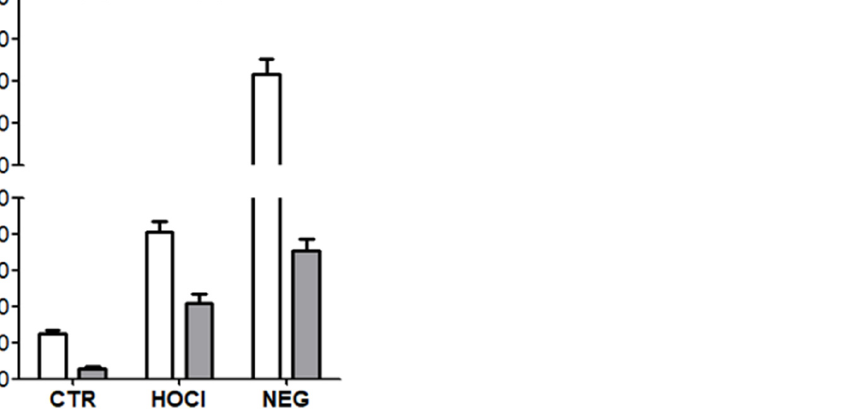
Figure A3. Carbonyl concentration in HOCl-CII and NEG-CII compared with the unmodified CII and the control changes in BSA. The bars represent the mean and SEM of at least 4 independent experiments.